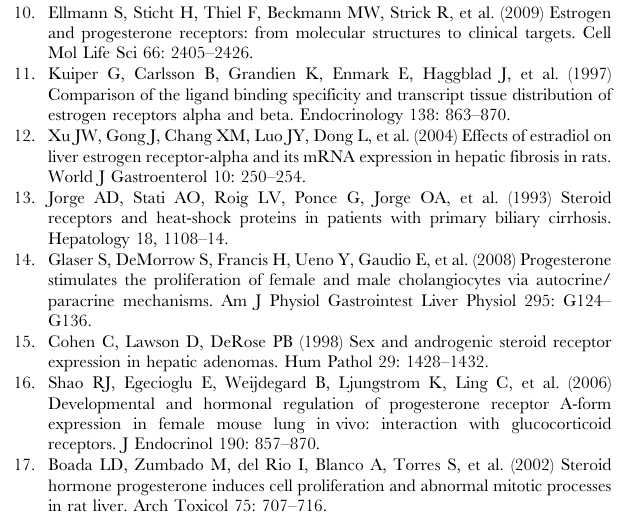
Table S1 Top 40 genes in the bovine liver that were differentially expressed in response to estradiol. Table S2 Top 40 genes in the bovine liver that were differentially expressed in response to progesterone. Table S3 Top 40 genes in the bovine liver that were differentially expressed in response to estradiol + progesterone